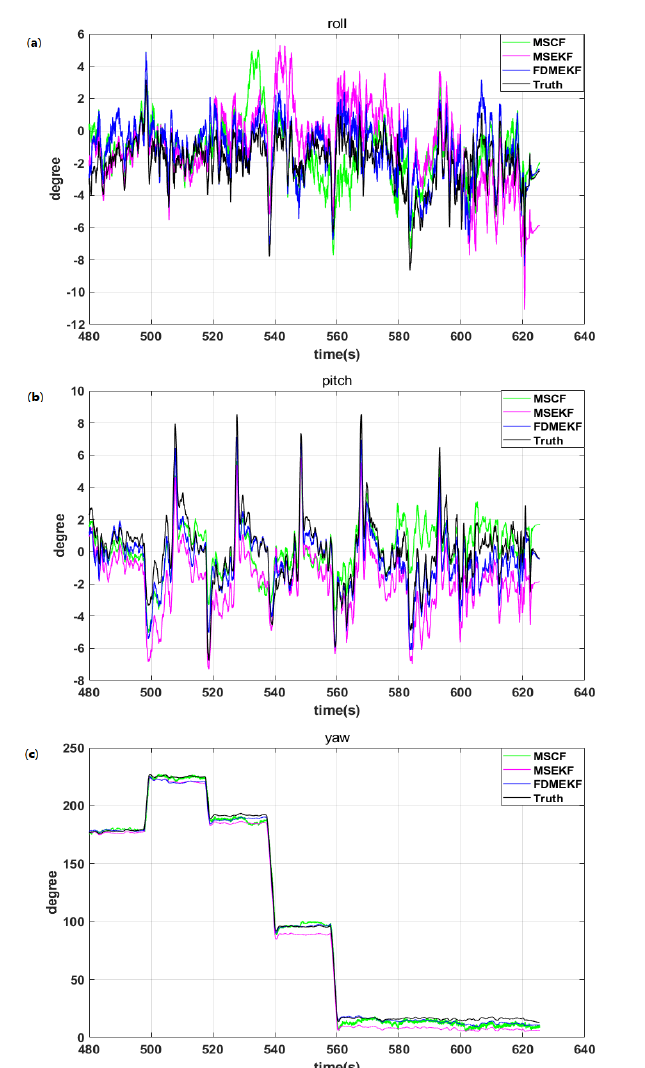
Figure 9. The attitude of the UAV in flight. ( a ) the roll of the UAV; ( b ) the pitch of the UAV; ( c ) the yaw of the